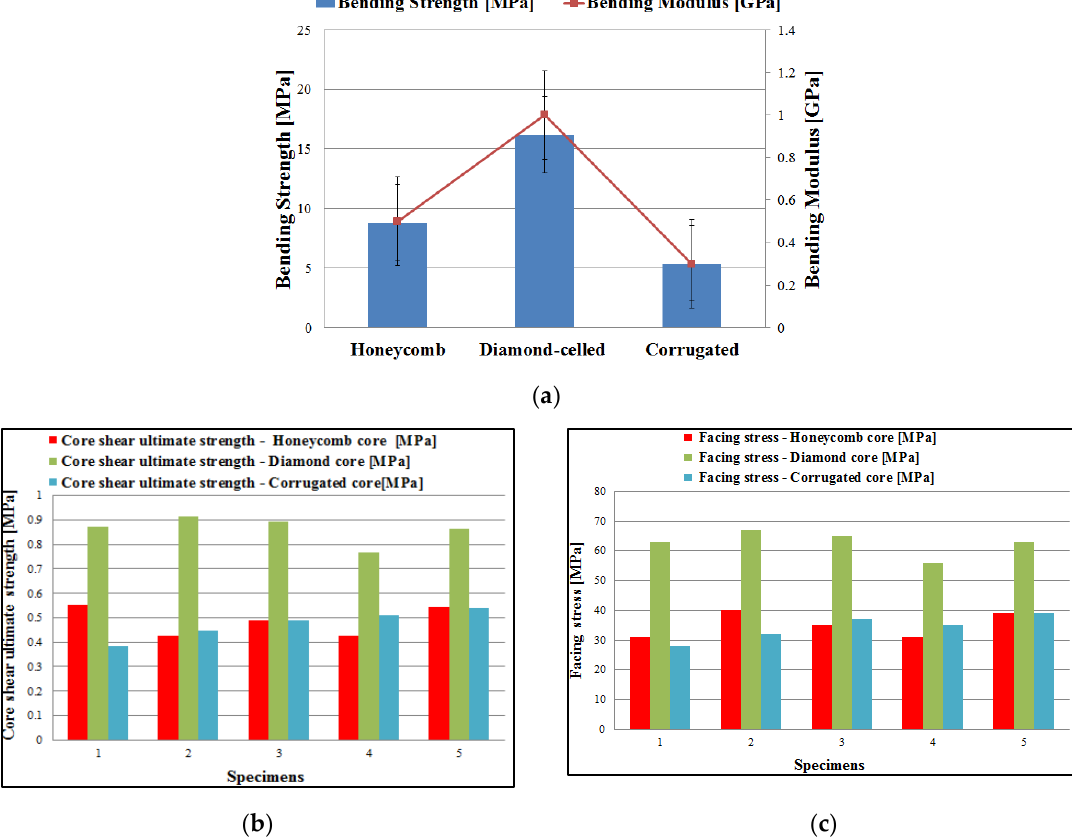
Figure 9. Experimental results: ( a ) the bending strength / modulus of the specimens; ( b ) core shear ultimate strength of the sandwich specimens; ( c ) facing stresses of the sandwich specimens.